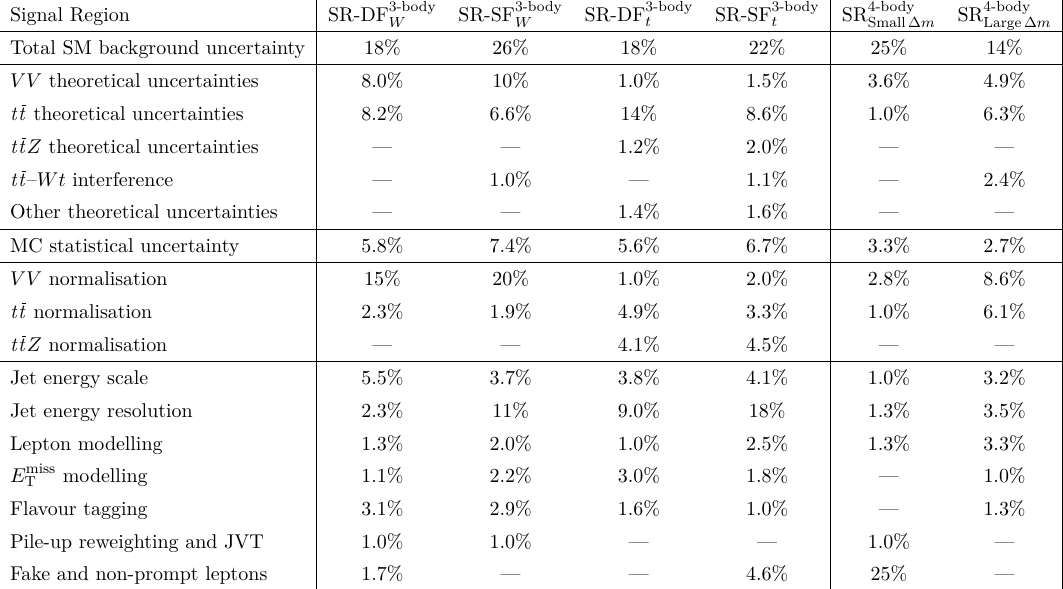
Table 14 . Three-body and four-body selections. Sources of systematic uncertainty in the SM background estimates, after the background fits. The values are given as relative uncertainties in the total expected background event yields in the SRs. Entries marked ‘–’ indicate a contribution smaller than 1%. ‘MC statistical uncertainty’ refers to the statistical uncertainty from the simulated event samples. ‘Other theoretical uncertainties’ represent the theoretical uncertainty coming